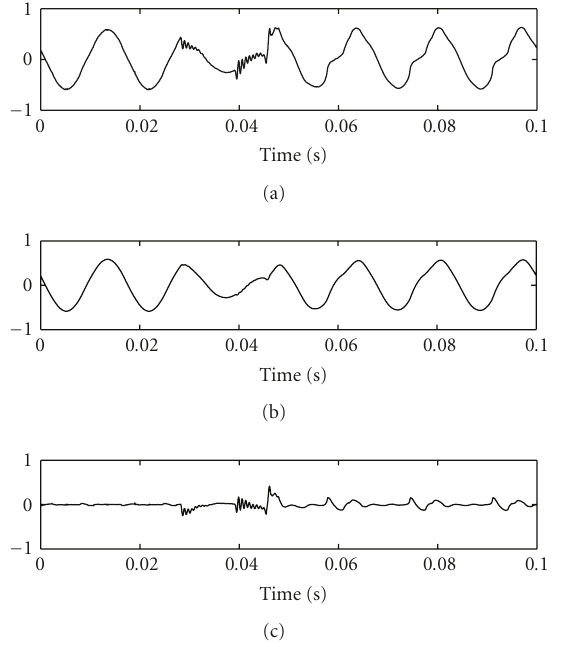
Figure 2: (a) Signal { x ( n ) } , (b) signal { f ( n ) } , (c) signal { u ( n ) } . interchange. The available voltage measurement were ob- tained with f s = 256 × 60Hz. The SNR of these data was estimated to be 40 dB.